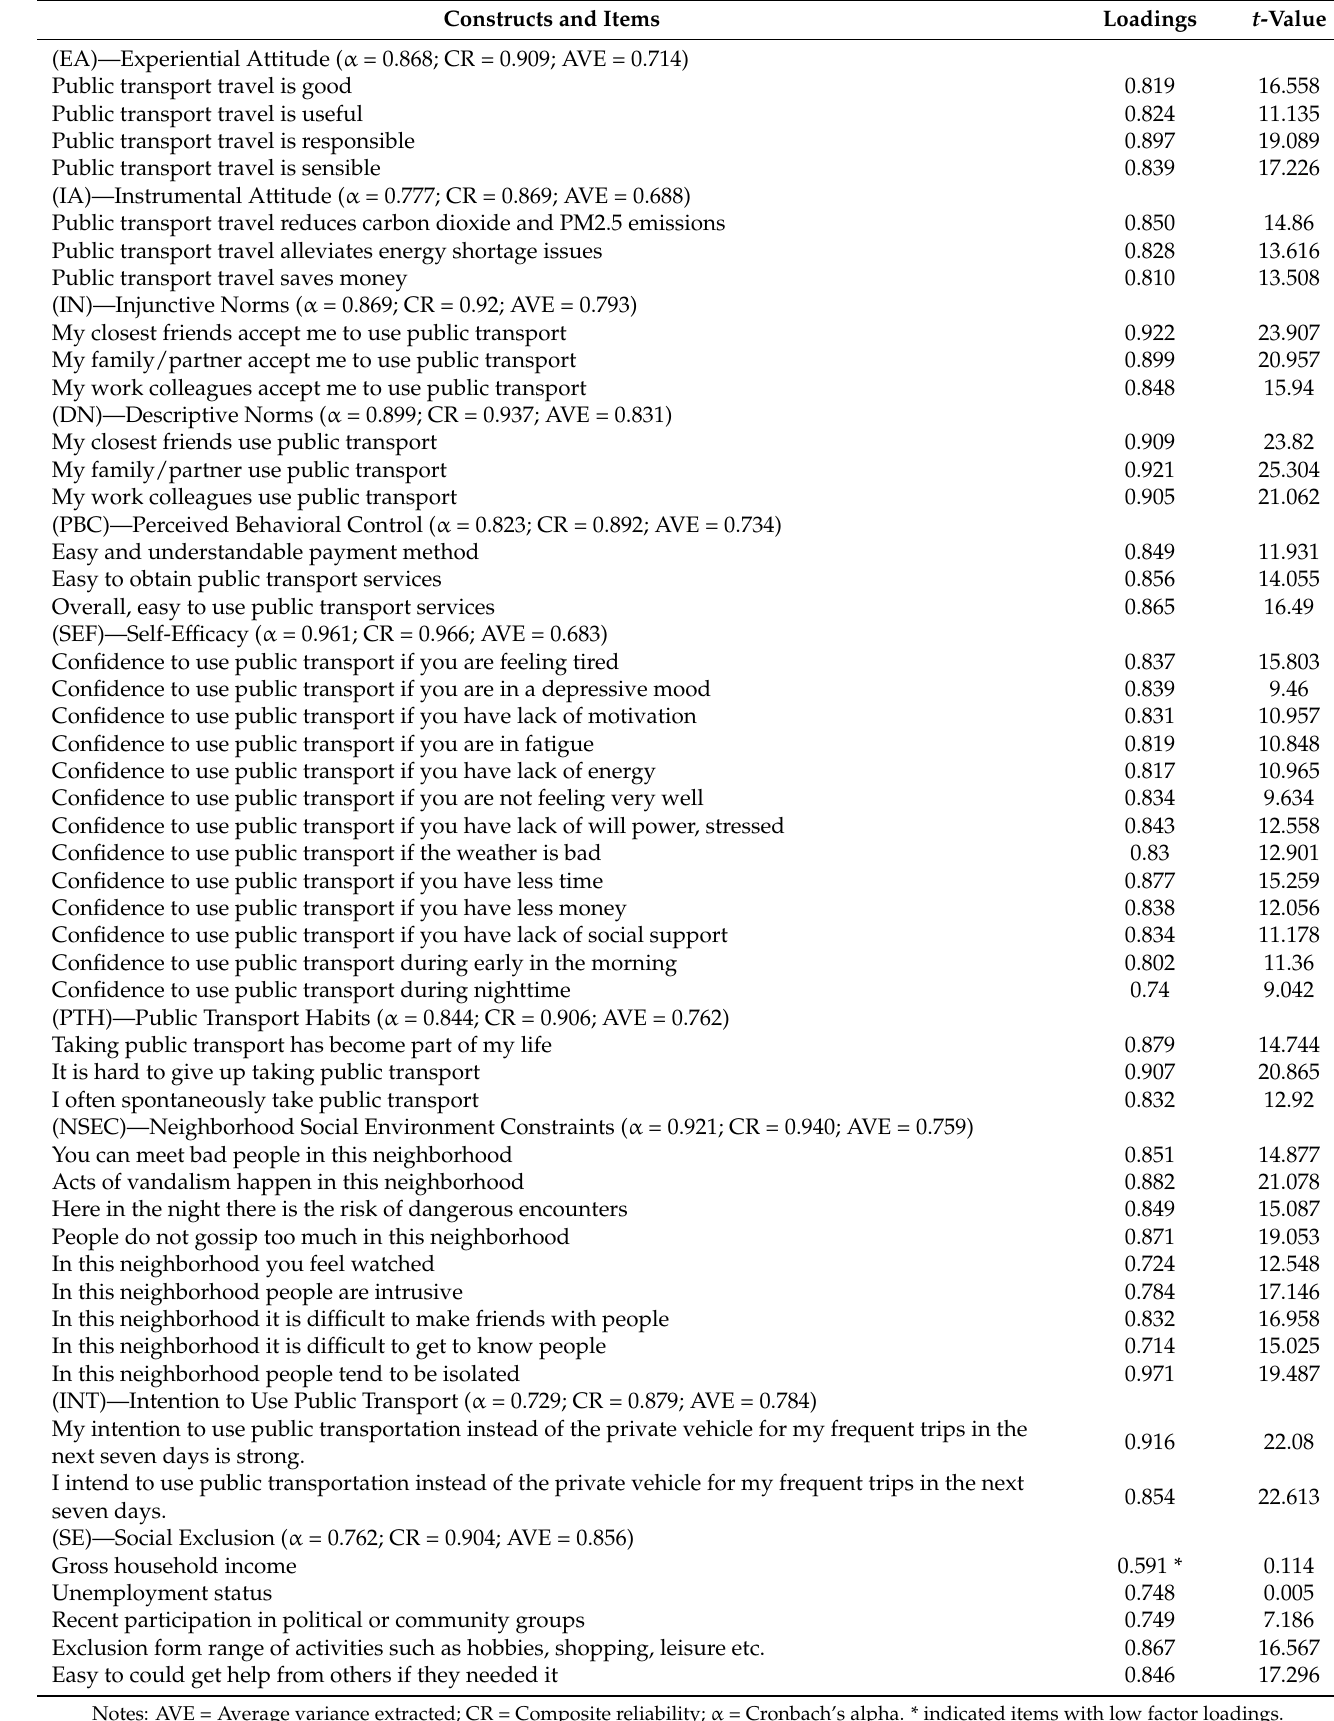
Table 1. Summary of the measurement